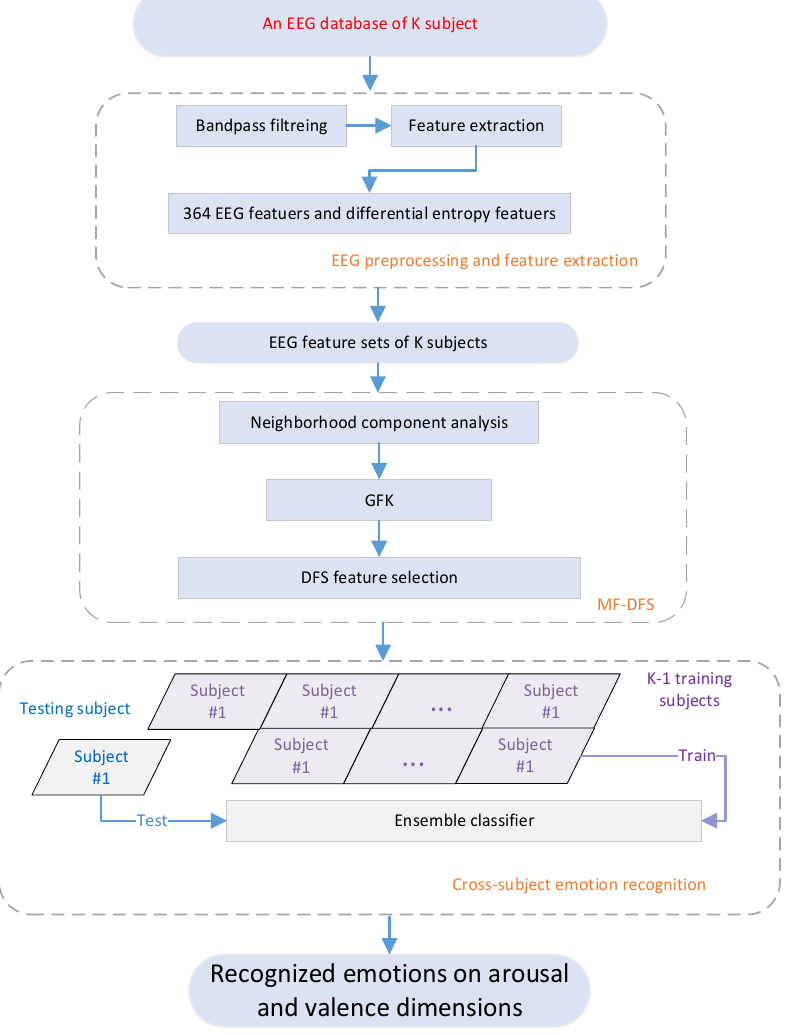
Figure 1. Emotion classification framework based on manifold feature fusion and dynamical feature selection method (MF-DFS).